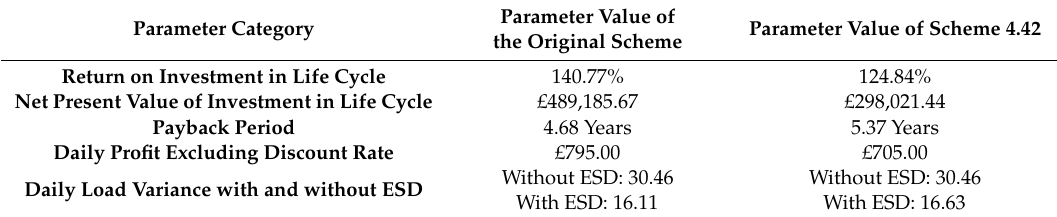
Table 4. Comparison of parameters of Scheme 4.42 with the original